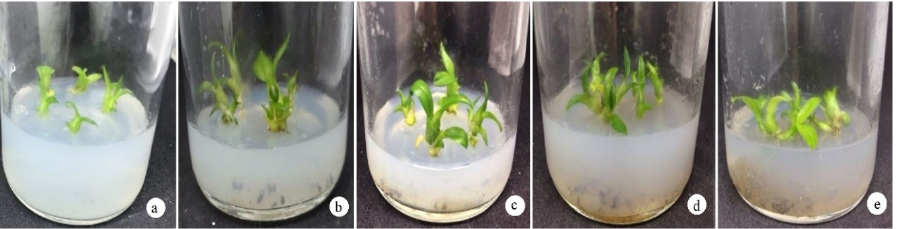
Figure 4. Effect of mashed banana on the growth and development of D. anosmum Lindl. (6 weeks after culturing): ( a ) MS, ( b ) MS + 10 g/L banana, ( c ) MS + 20 g/L banana, ( d ) MS + 30 g/L banana, and ( e ) MS + 40 g/L banana.